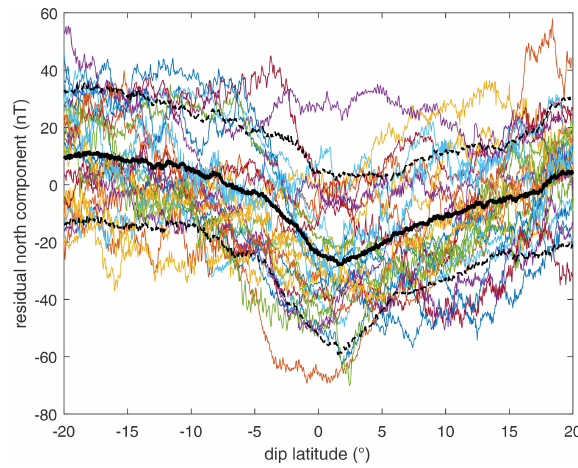
Figure 16. The residual north components of different orbits af- ter removing the core field, crustal field, and the magnetospheric field calculated from the CHAOS-7 model. Different colored lines indicate measurements from different orbits. The thick black line referred to the averaged values of all the orbits. Two dashed black lines indicate the standard deviation